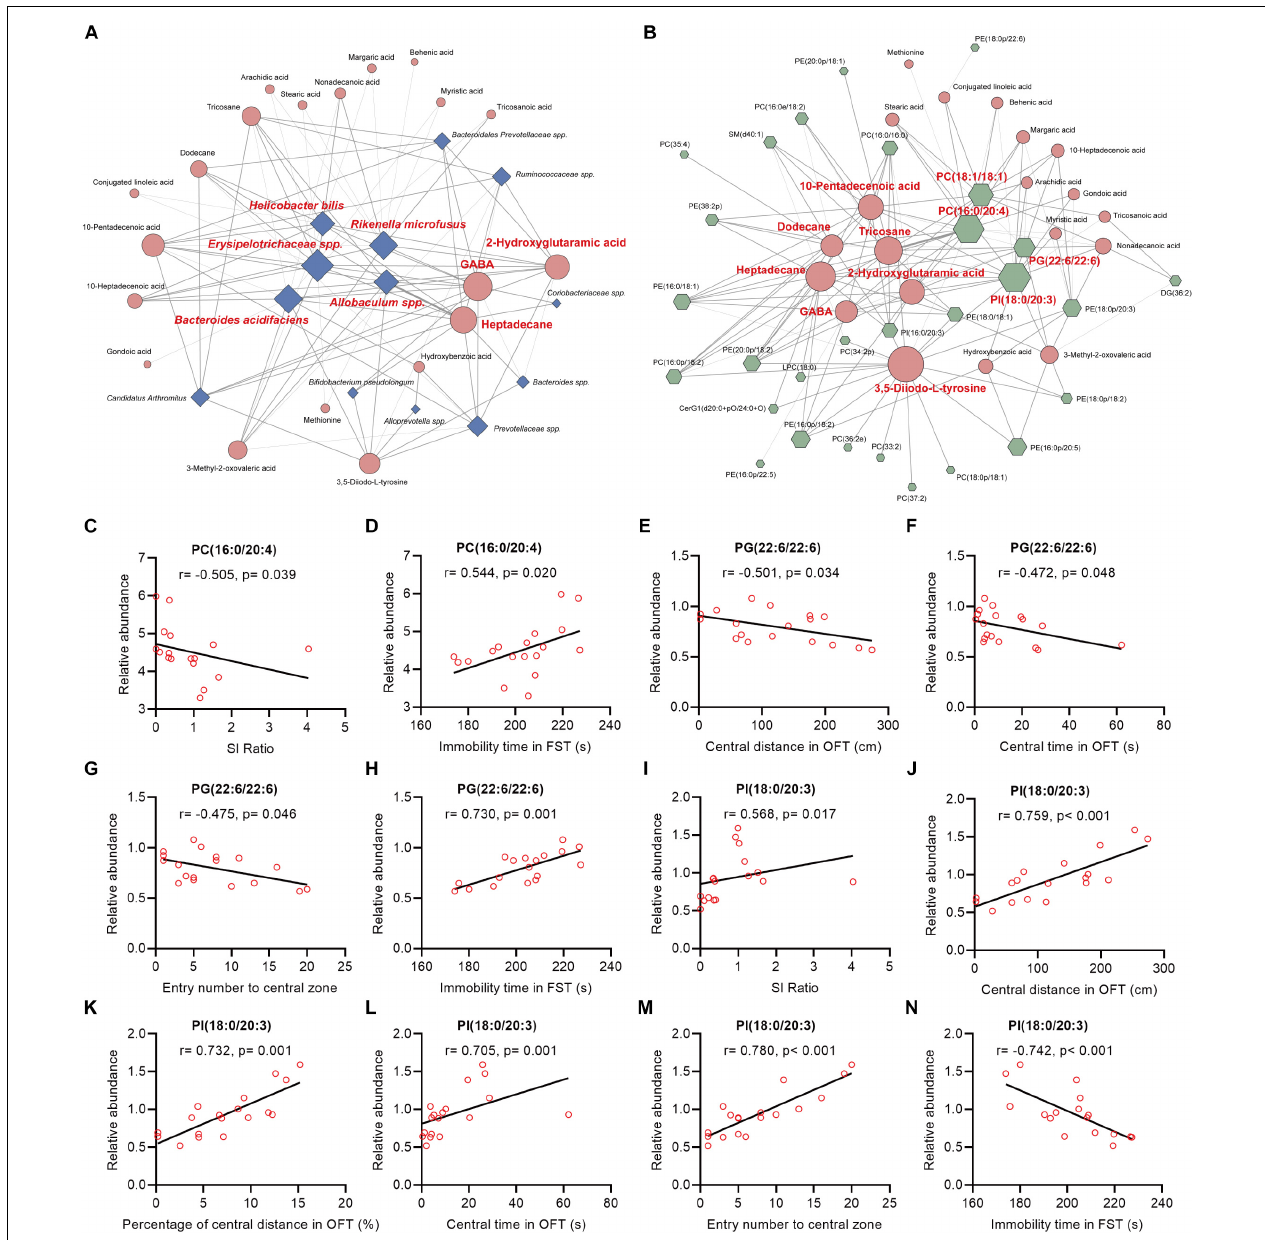
FIGURE 5 | Spearman’s correlations between the differential bacteria species, fecal metabolites, colonic lipids, and behavior indices. (A,B) The network maps illustrated correlations between the differential bacteria species and fecal metabolites, and between the differential fecal metabolites and colonic lipids, respectively. Blue nodes represent bacteria species; orange nodes represent fecal metabolites; and green nodes represent colonic lipids. Edges between nodes represent Spearman’s correlation. The node size corresponds to the number of correlations, that is, a larger node for bacteria taxa indicates it linked to more fecal metabolites. Nodes (the number of correlations over or equal to 10) were marked in red. The edge width corresponds to correlation coefficient. (C–N) The correlation analysis between PC(16:0/20:4), PG(22:6/22:6), PI(18:0/20:3), and behavioral index,